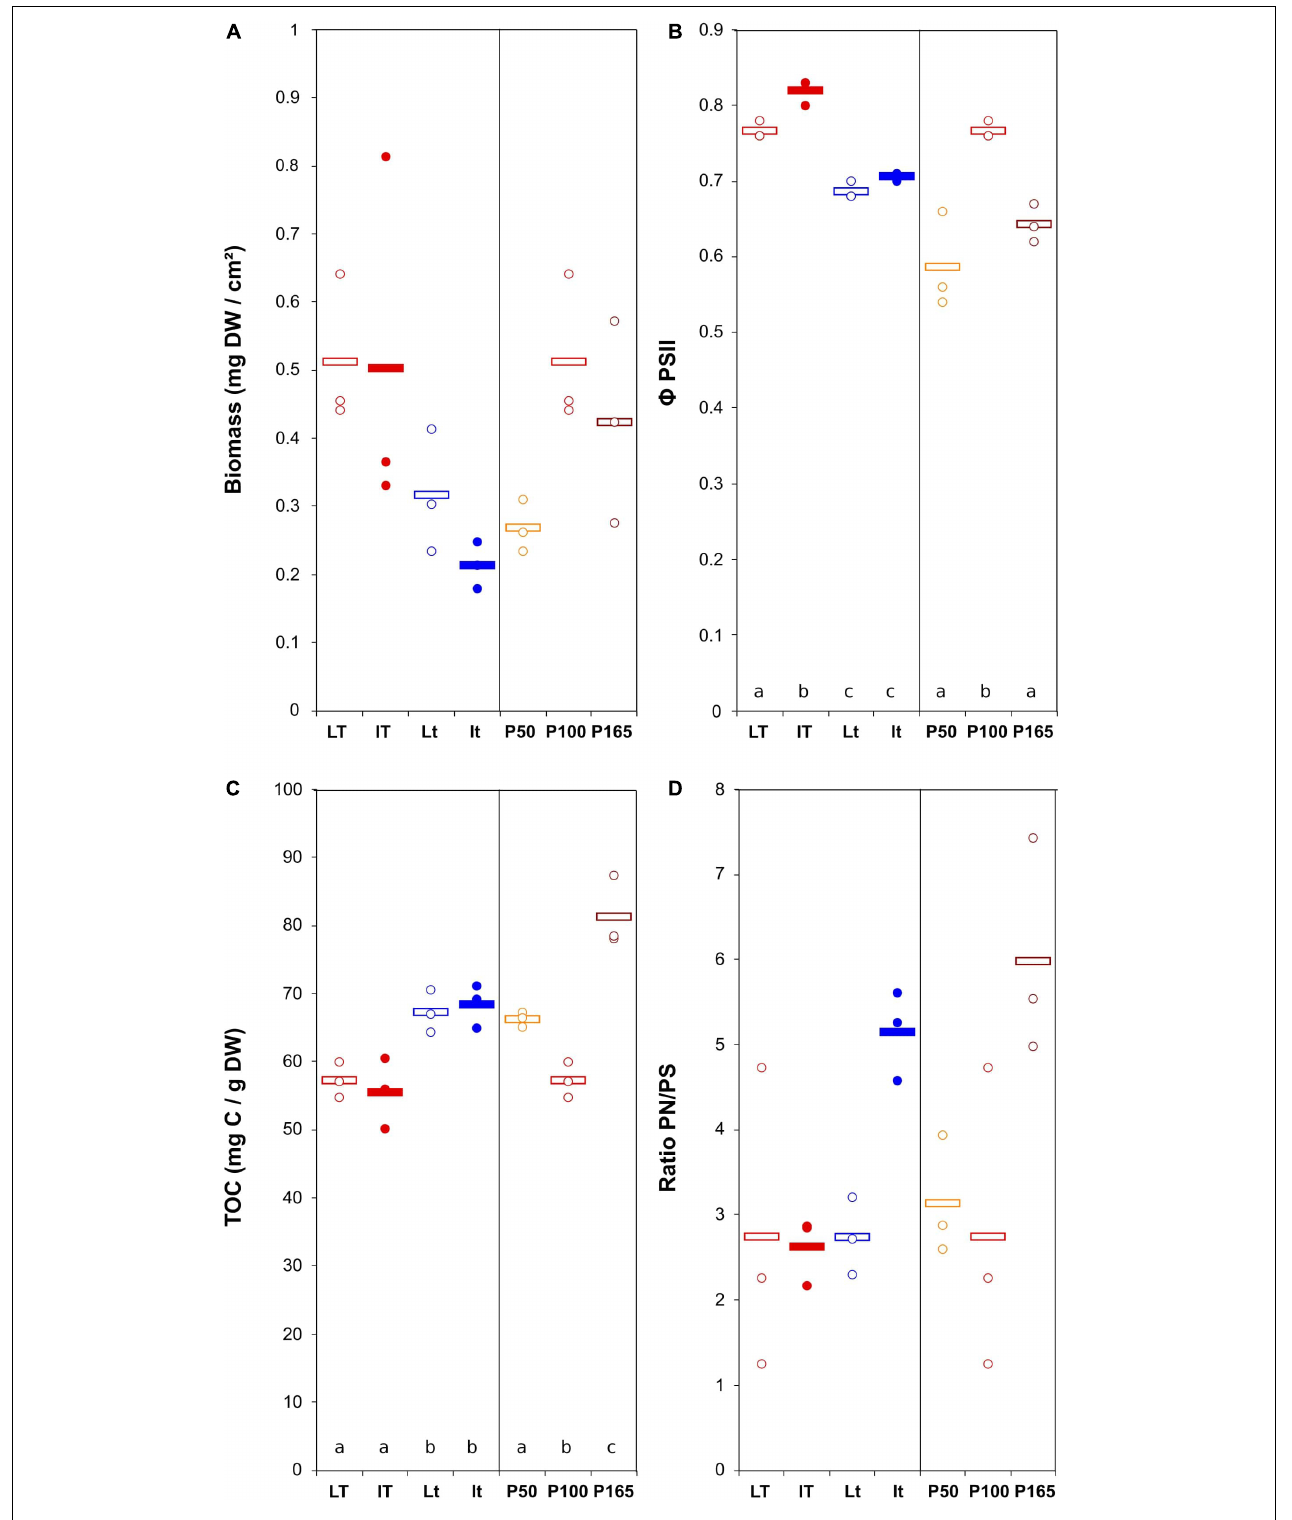
FIGURE 2 | Scatter plot of the biomass ( DW = dry weight) (A) , maximum quantum yield (B) , total organic carbon (quantity of EPS) (C) , and ratio protein/polysaccharide in the EPS (D) in N. palea biofilm before the disturbance. The letters indicate statistically homogeneous groups (Tukey post hoc test after ANOVA). No letters for non-significant ANOVA (the bars represent the means, n = 3). L/l: high/low light intensity (P100), T / t : high/low temperature (P100), P50, P100, P165: 50, 100, and 165% of the standard initial phosphorous concentration, respectively, associated with L and T conditions.